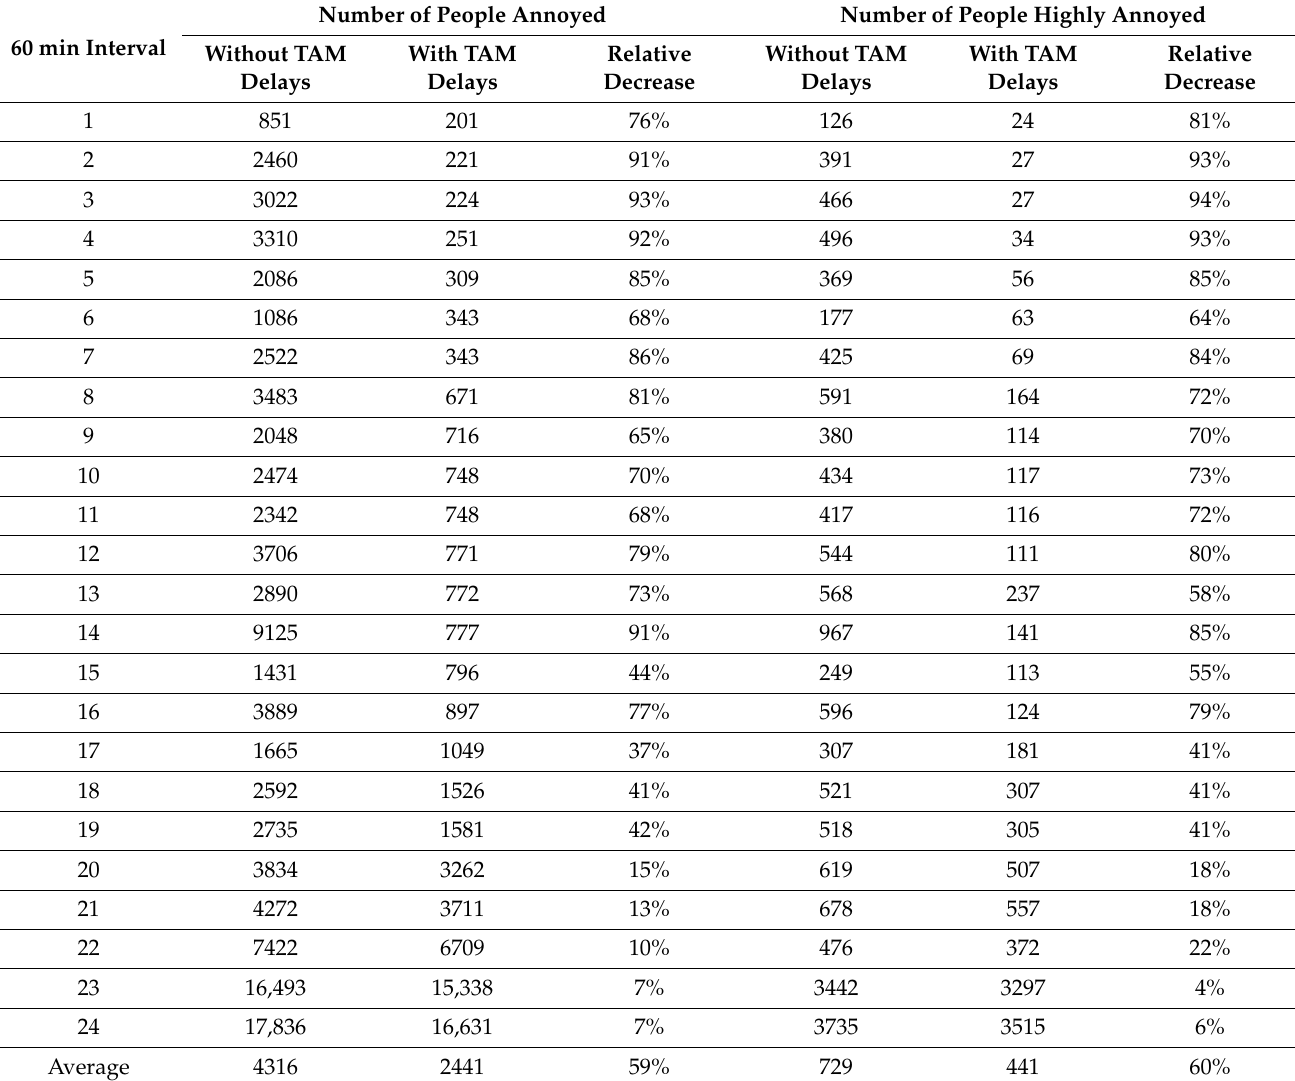
Table A3. Number of people annoyed and highly annoyed per interval (Niš